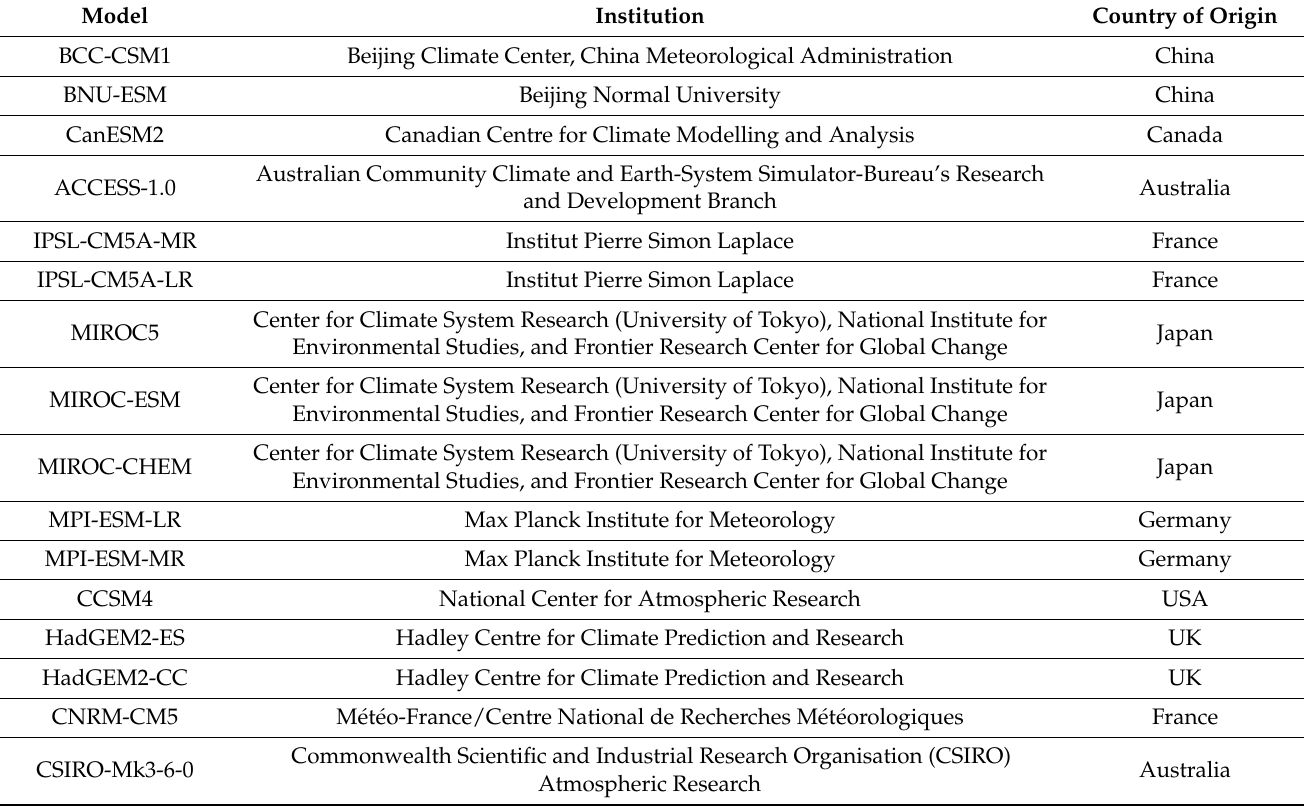
Table 2. List of initial pool of climate models used in this